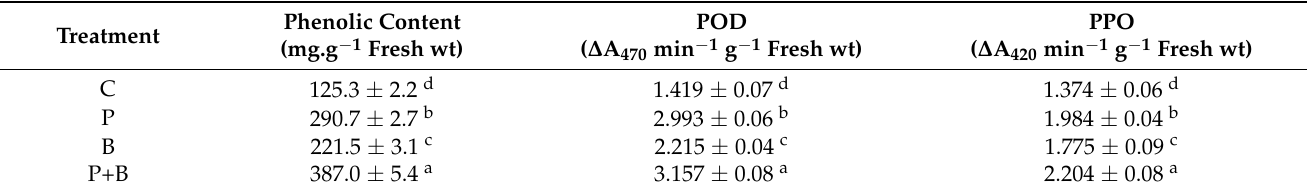
Table 4. Mean phenolic content and activity of peroxidase (POD) and polyphenol oxidase (PPO) enzymes in roots of tomato plants infected with Rhizoctonia root rot and treated with Bacillus subtilis SR22 at 45 dpi *.